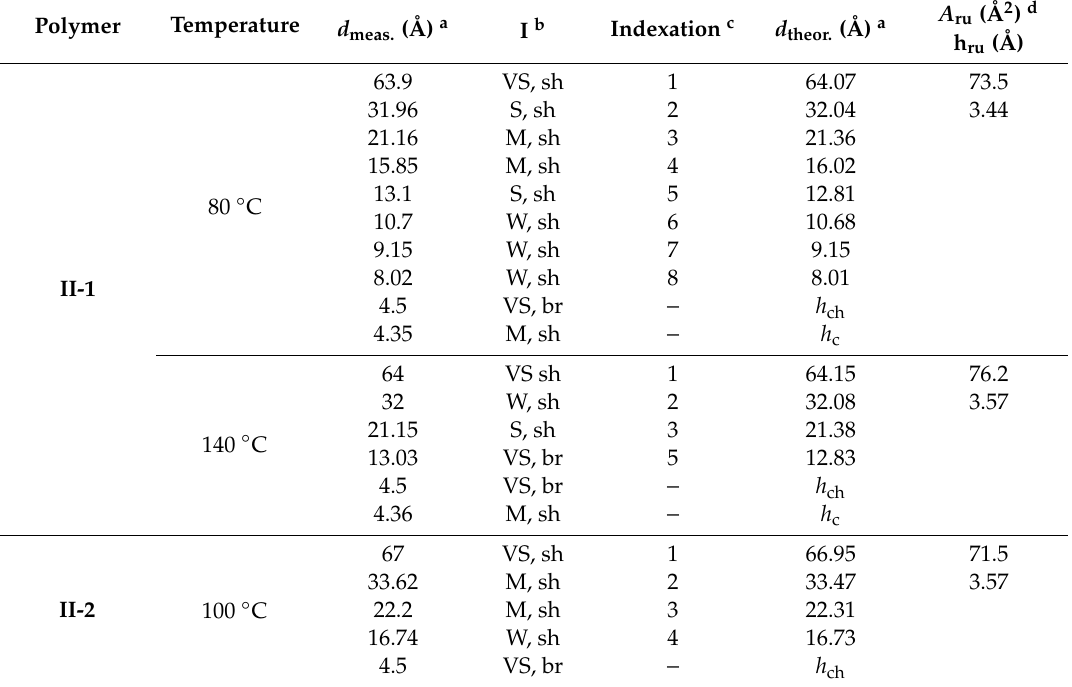
Table 2. XRD data for polymers II-1 and